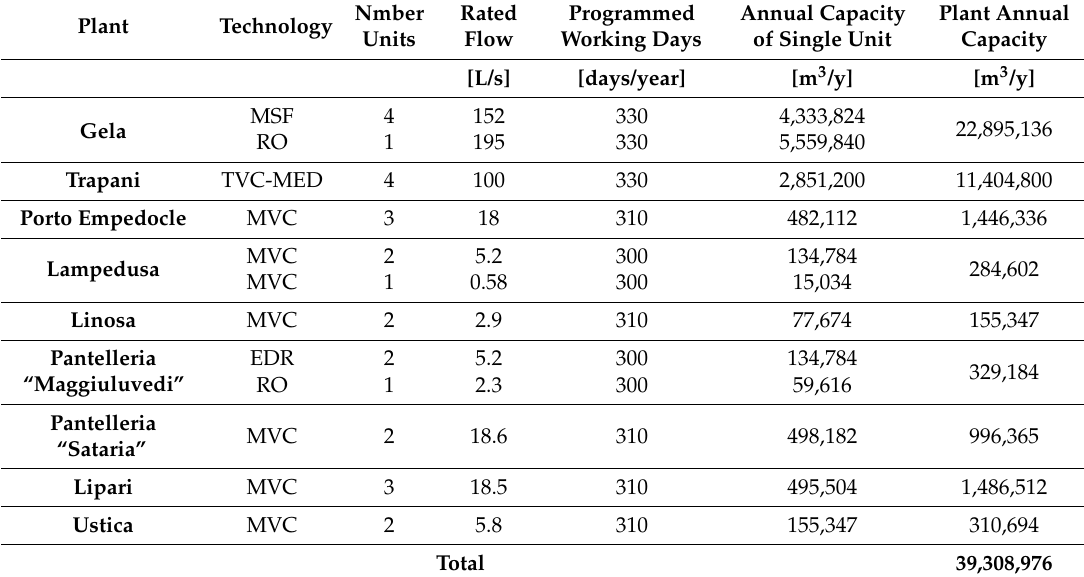
Table 1. Desalinations plant installed in Sicily and small